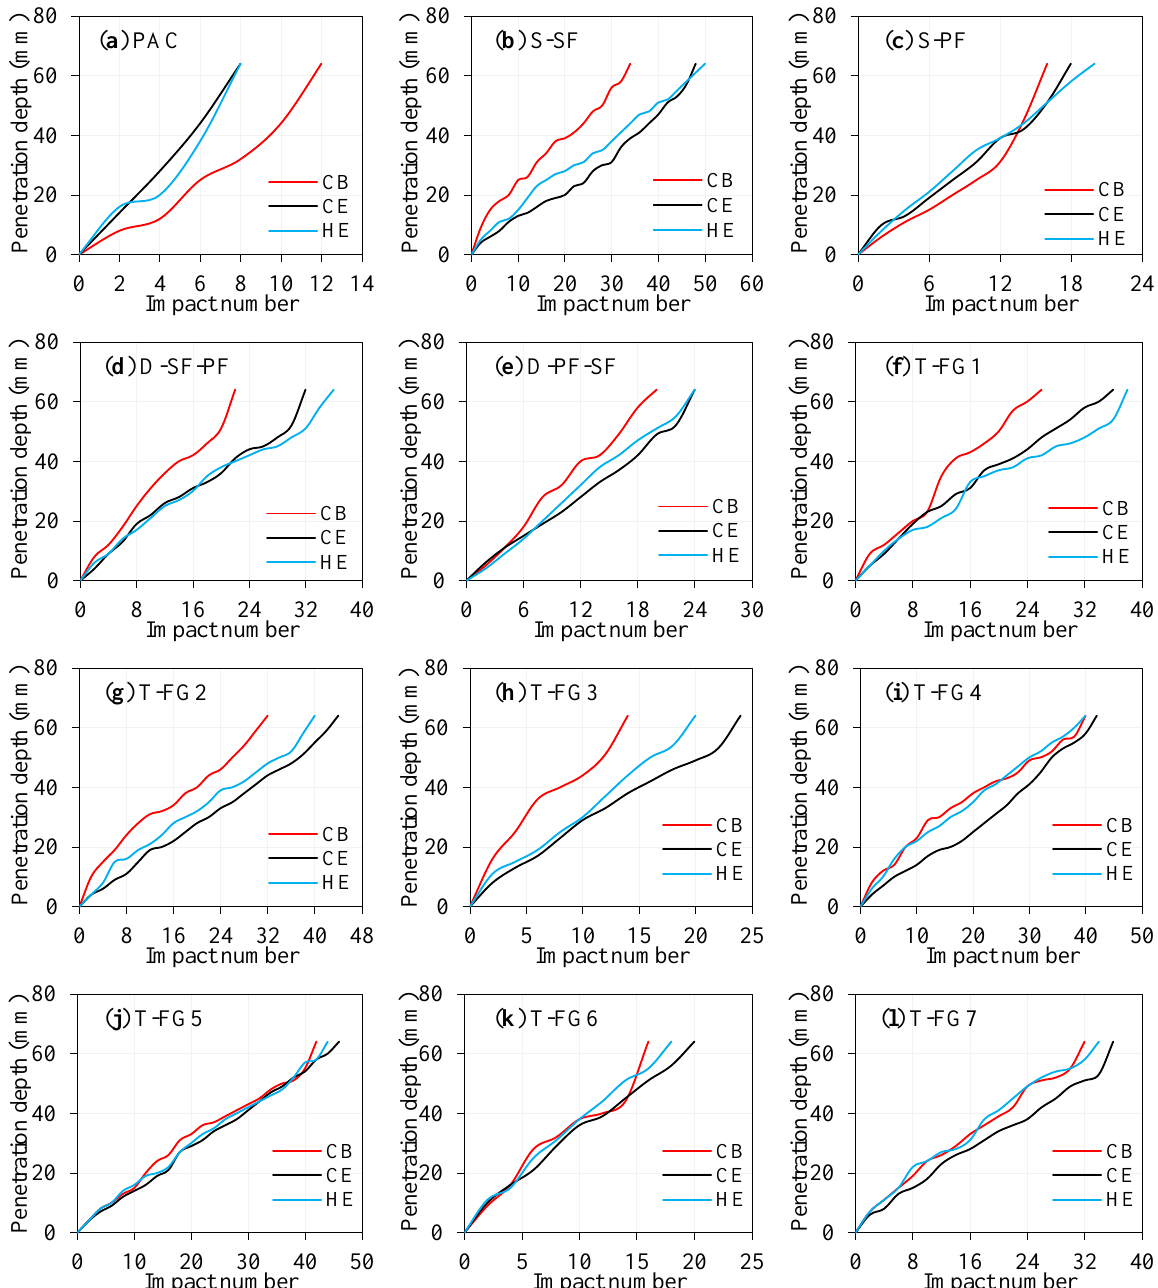
Figure 15. Results of measured depth of penetration under repeated projectile.